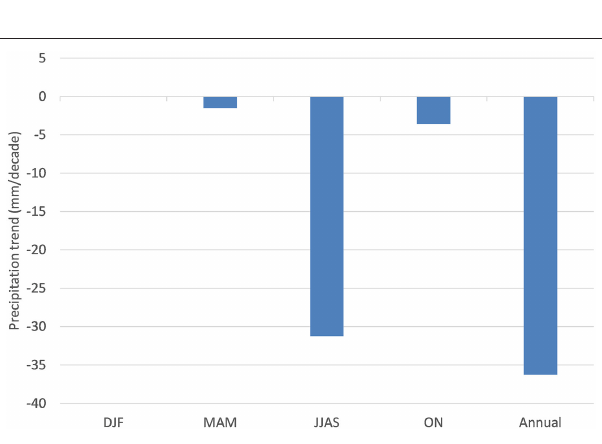
FIGURE 8 | Precipitation trends in the study area based on CRU data